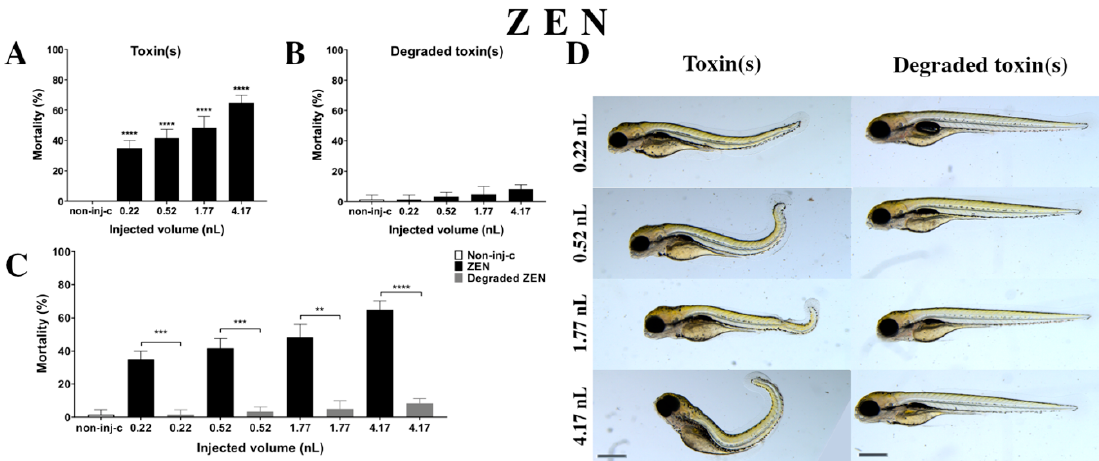
Figure 3. Effects of ZEN ( A ) and its degradation products ( B ) by the Rhodococcus erythropolis NI1 strain on 120 hpf zebrafish embryos. Mortality data are expressed as mean ± SD from three independent experiments in triplicates. Kruskal–Wallis followed by Dunn’s post-hoc test and Mann–Whitney test were used. Mortality values were compared to the non-injected control (non-inj-c) (**** p < 0.0001); lethality results of the initial ZEN were compared to the degradation products of ZEN ( C ) (** p < 0.01, *** p < 0.001, **** p < 0.0001). ZEN and its degradation products induced developmental dysfunctions ( D ) in zebrafish embryos examined at 120 h. Representative phenotypic deformities induced by ZEN were tail deformities, head and lens distortion, reduced pigmentation, and swim bladders were not developed at either dose; sublethal effects of its degradation products were not detected at either dose. Scale bar: 1 mm. Phenotypes of treated groups were compared to the non-injected control (non-inj-c) (Figure 1C). Quantitative data of developmental dysfunctions in zebrafish embryos are in the Supplementary Materials (Supplementary Table S1).